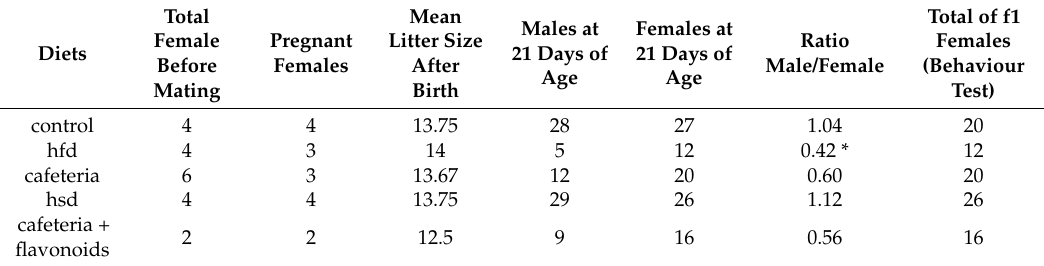
Table 1. Effect of nutritional programming on breeding and female offspring survival at 21